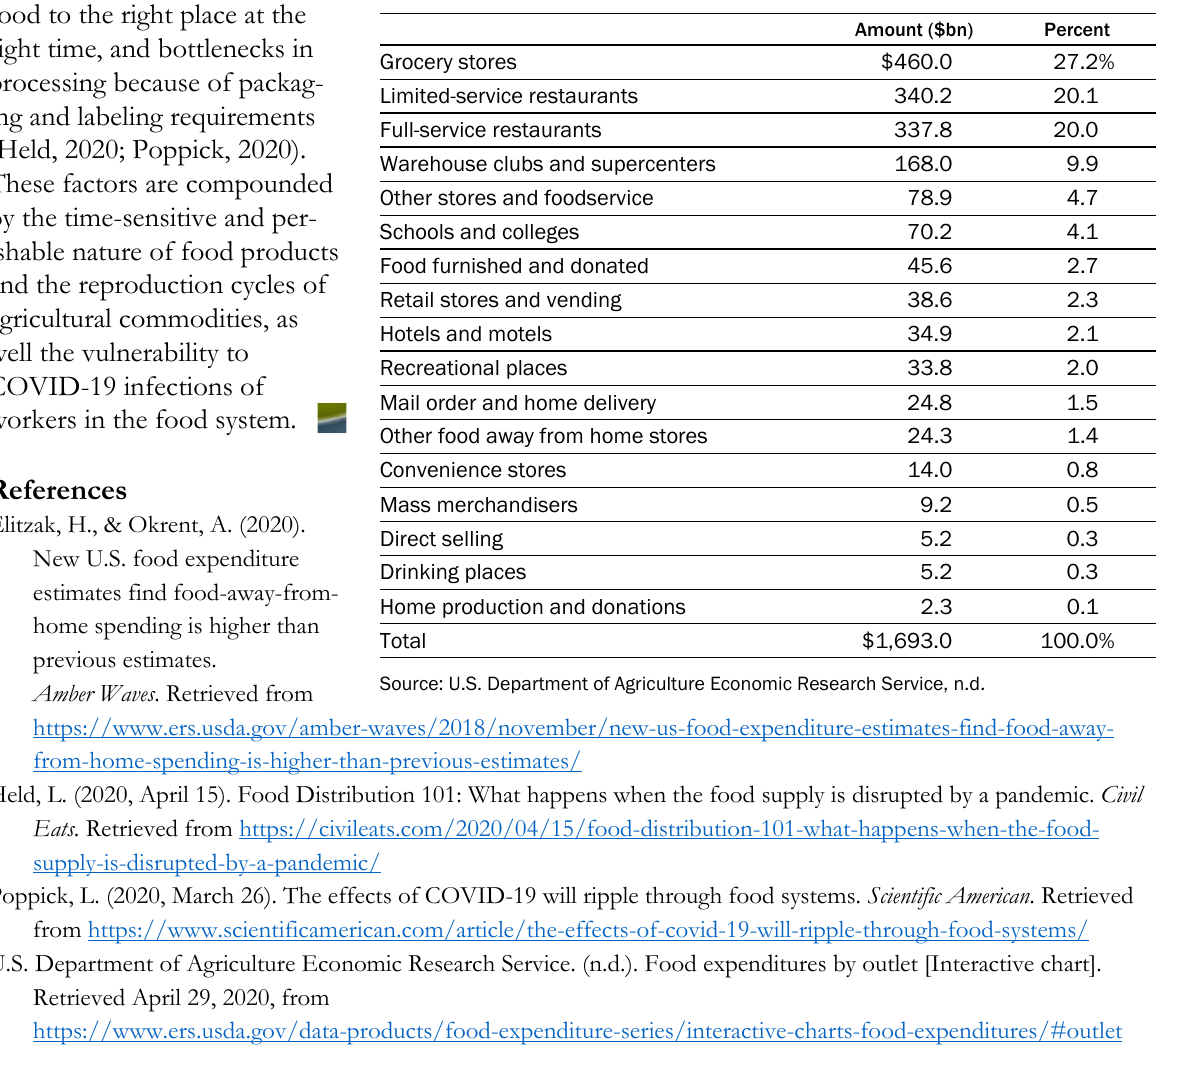
Table 1. U.S. Food Expenditure by Outlet,